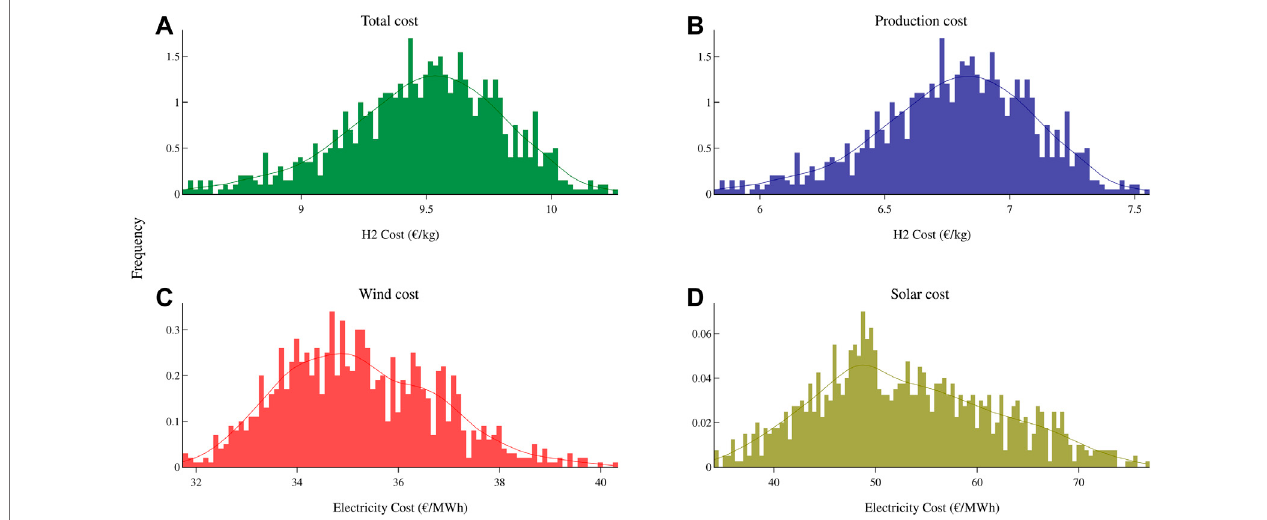
FIGURE 10 | Distributions of the total (delivered) H 2 cost including transport (A) , the production cost (B) , and the cost of wind (C) and solar (D) electricity from the Monte Carlo analysis (1,000 iterations) of the baseline scenario (100 kt/y AE electrolyser in 2030, H 2 usage location in Cologne, centralised reconversion). The distributions represent the costs of the production site with the lowest total cost of H 2 per kg, in Cairo, Egypt.